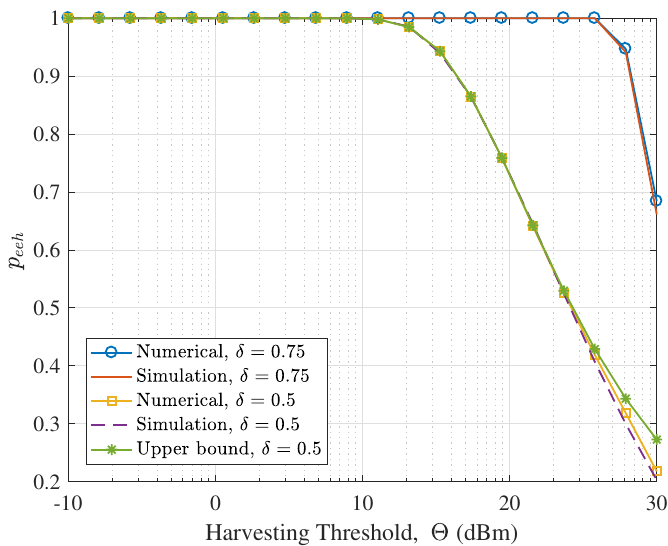
Figure 4. Effective energy harvesting probability for LSWN-noIC with λ t = 0.1, α = 4, η a = 1 and P et = 30 dBm.